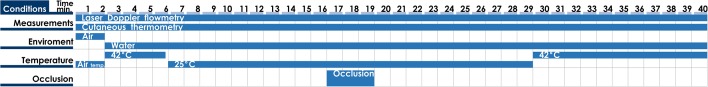
Time chart of the study protocol of simultaneous measurements of the blood perfusion and skin temperature.